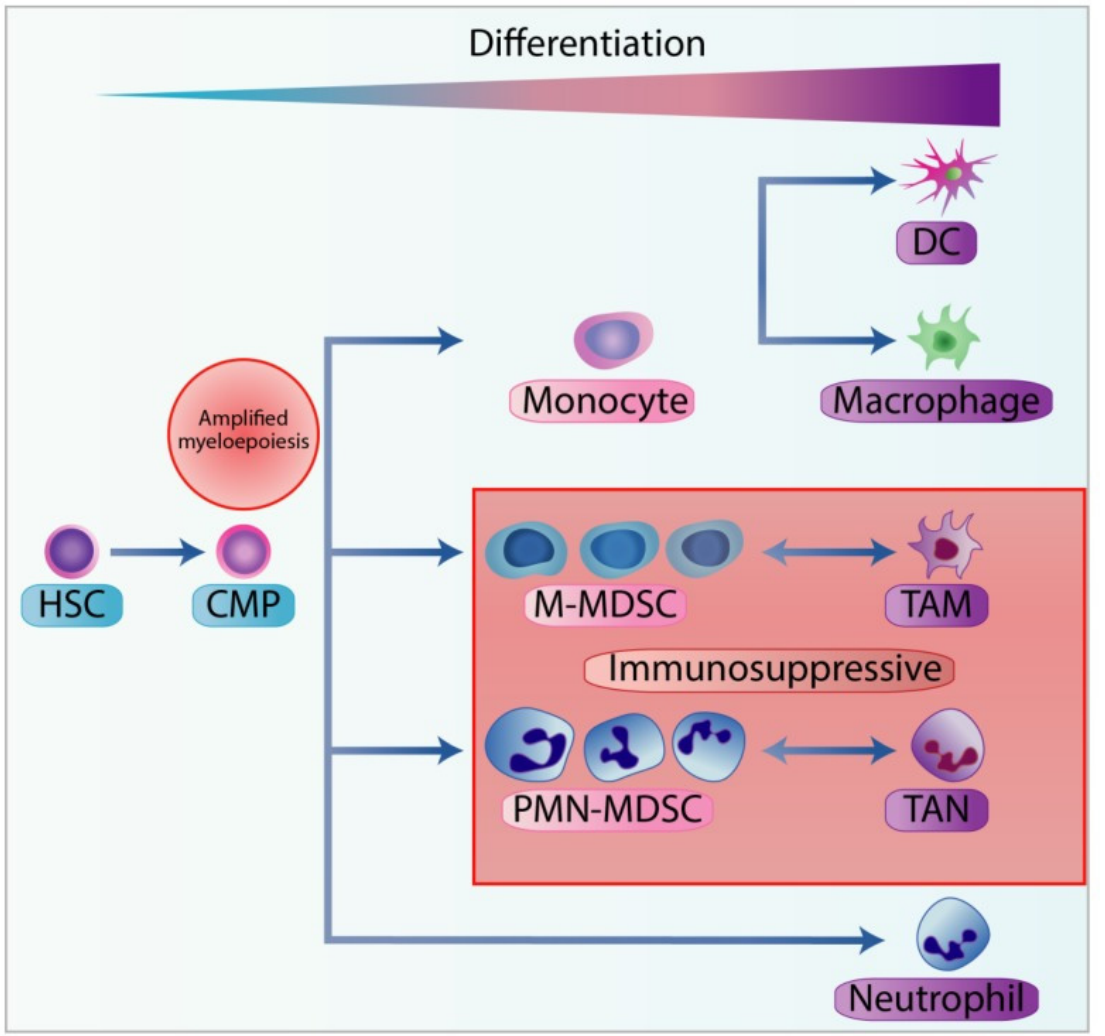
Figure 7. Stages of myelopoiesis differentiation in cancer. Myelopoiesis is amplified during chronic inflammation to assist tumour progression and dissemination. The hematopoietic stem cells (HSC) differentiate into the common myeloid progenitor (CMP), which can further differentiate through the hematopoietic system. In physiological conditions, CMP can differentiate into neutrophils or into monocytes, and subsequently into dendritic cells (DC) or macrophages. However, with chronic inflammation, pro-inflammatory cytokines can skew the monocytopoiesis of CMP into monocytic-myeloid-derived suppressor cells (M-MDSC) and tumour-associated macrophages (TAM), and granulopoiesis into polymorphonuclear myeloid-derived suppressor cells (PMN-MDSC) and tumour-associated neutrophils (TAN). From Law et al [87].